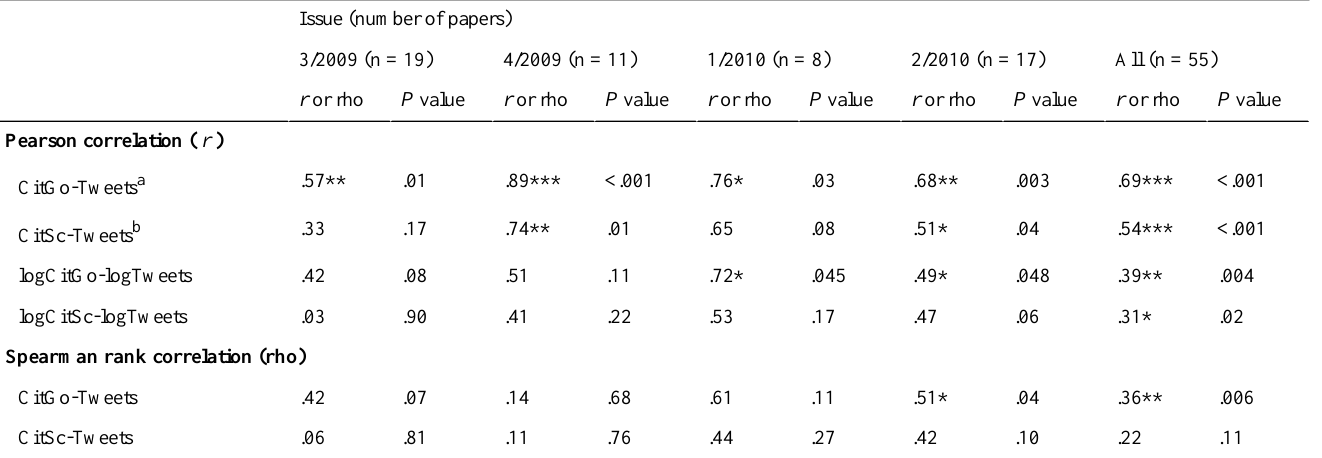
Table 1. Correlation coefficients